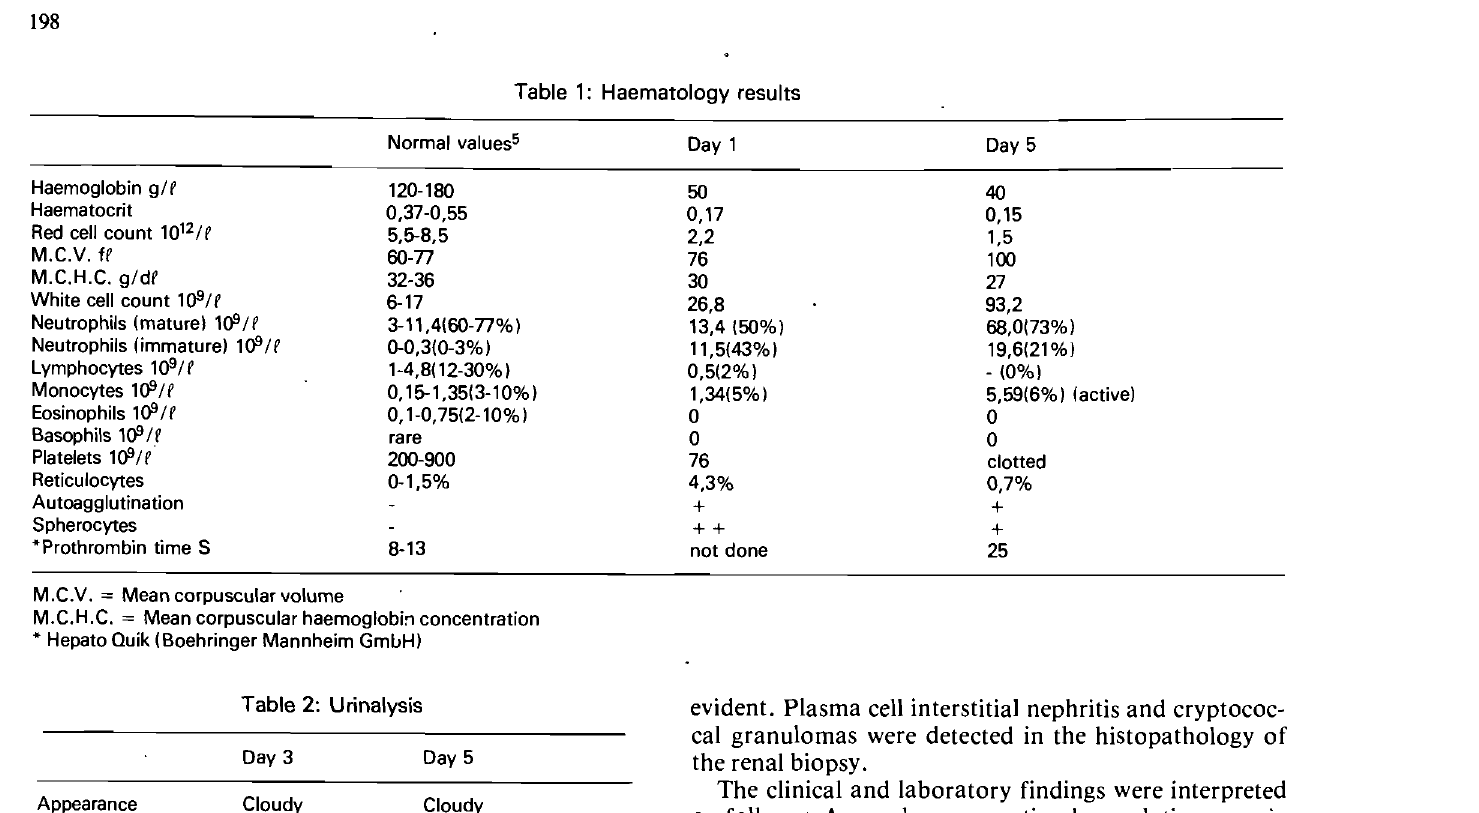
Table 2: Urinalysis